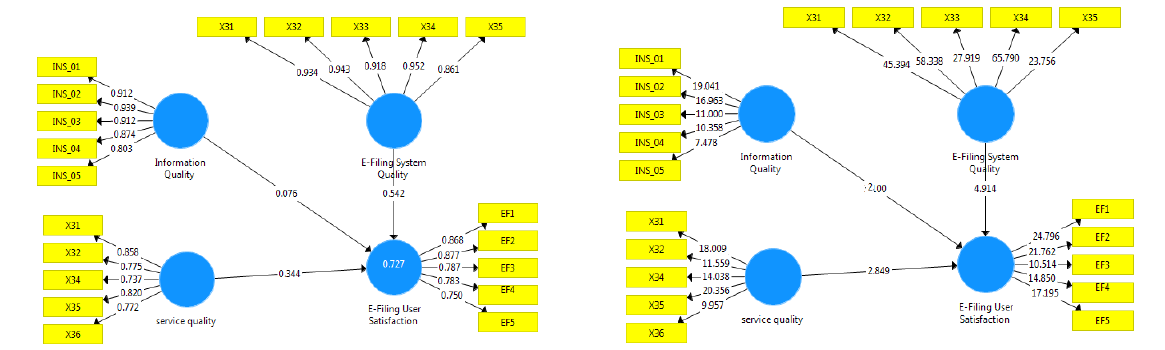
Fig. 2. Validity and reliability testing Fig. 3. Hypothesis testing